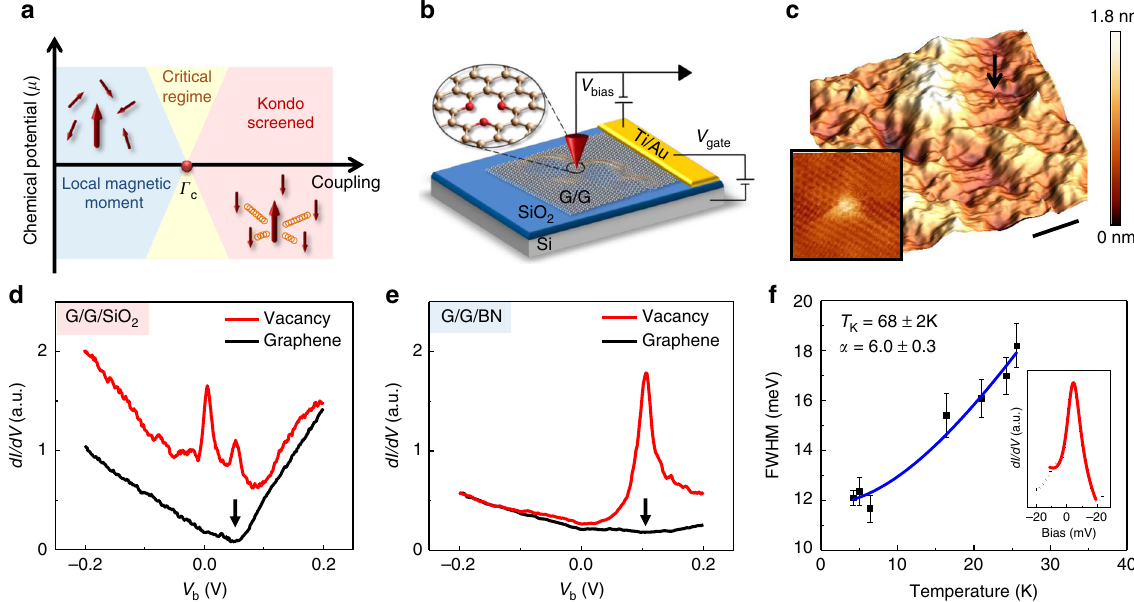
Fig. 1 Kondo peak at a single-atom vacancy in graphene. a Schematic phase diagram of the pseudo-gap Kondo effect. The critical regime (yellow) separates the Local-magnetic-moment phase from the Kondo-screened phase. Arrows represent the ground state of the system with the large arrows corresponding to the local spin and the smaller ones representing the spins of electrons in the conduction band. b Schematics of the experimental setup. c STM topography of a double layer graphene on SiO 2 (G/G/SiO 2 ). The arrow indicates an isolated vacancy ( V b = − 300mV, I = 20pA, V g = 50 V). The scale bar is 20 nm. Inset: atomic resolution topography of a single atom vacancy shows the distinctive triangular structure (4 nm × 4 nm), V b = − 200mV, I = 20pA, V = − 27V. d dI / dV spectra at the center of a single atom vacancy (upper red curve) and on pristine graphene far from the vacancy (lower black curve). g The curves are vertically displaced for clarity ( V b = − 200mV, I = 20pA, V g = 0 V). The arrow labels the Dirac point. e Same as d but for a vacancy in a G/ G/BN sample ( V b = − 200mV, I = 20pA, V g = − 30V). f Evolution of the measured full width at half maximum (FWHM) of the Kondo peak with temperature (black data points) shown together with the fi t (blue solid line) discussed in the text. Error bars represent the linewidths uncertainty obtained from fi tting the Kondo peak to a Fano lineshape. Inset: Zoom into the Kondo peak (black dotted line) together with the Fano lineshape fi t (red solid